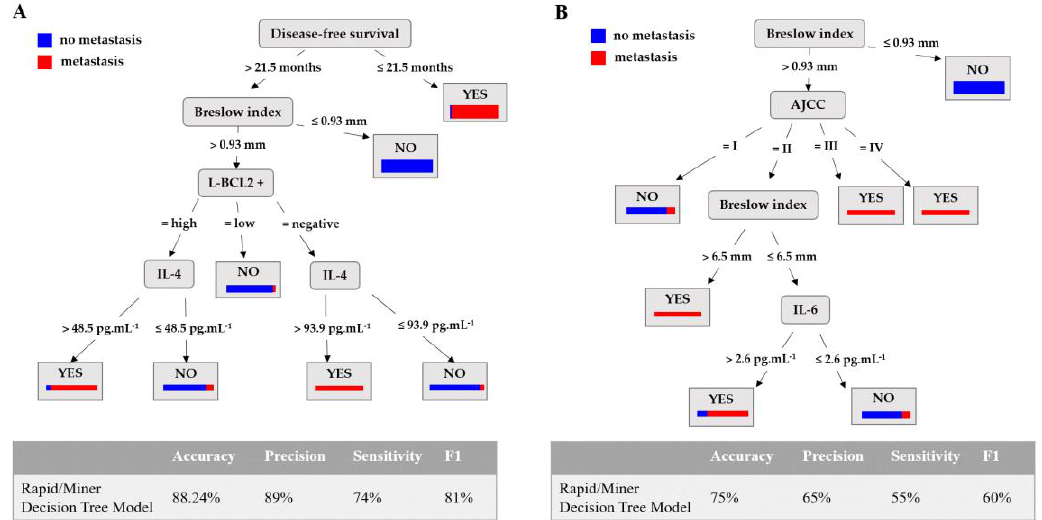
Figure 5. The RapidMiner decision tree model used to predict the development of metastasis. ( A ) The performance of the models obtained to predict the development of metastasis and the set of rules are shown in Figure S2A,B: disease-free survival is expressed in months; the Breslow Index in mm; L-BCL2 + represents the quantification of the intratumoral BCL2-positive lymphocytes expressed as No (absence of BCL2 + intratumoral lymphocytes), Low (presence of a small number of BCL2 + intratumoral lymphocytes), and High (presence of a large number of BCL2 + positive intratumoral lymphocytes); serum IL-4 is expressed in pg·mL −1 . ( B ) The RapidMiner decision tree model trained with the original 196 patients but without the attribute disease-free survival (see rules in Figure S3A). The attributes used to predict metastasis are Breslow index, stage according AJCC, and IL-6-serum levels in pg·mL −1 .